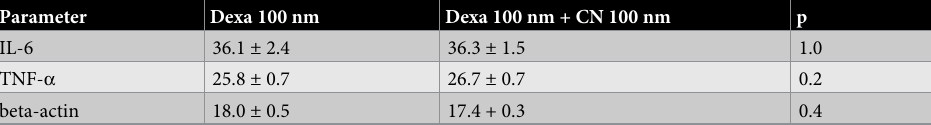
Table 2. Detection of IL-6 and TNF- α in AR42J cells.